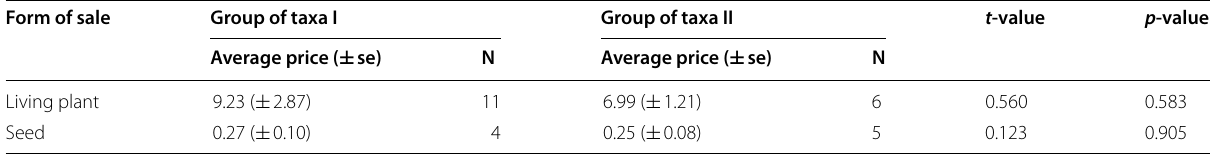
Table 5 Average prices in Euros standard error for two forms of sale of the endemic plants of Crete, Greece, and results ± of t-test